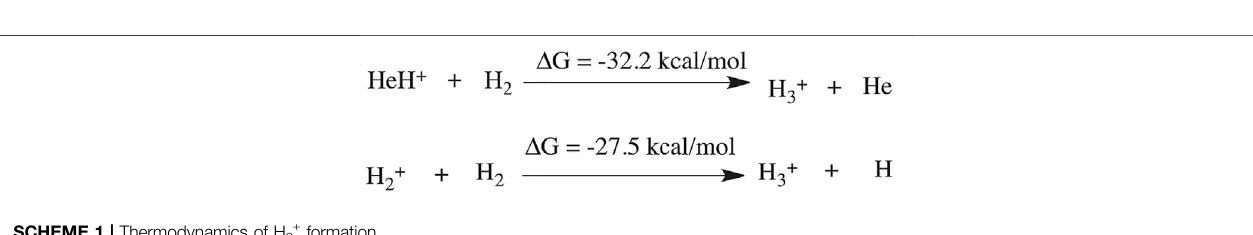
SCHEME 1 | Thermodynamics of H 3+ formation.